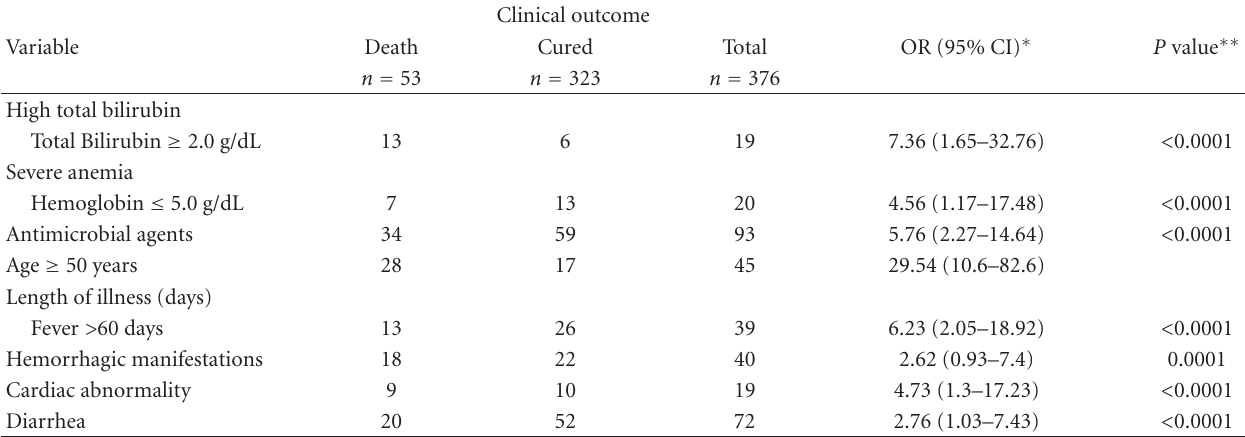
Table 4: Final model of factors associated with VL lethality, state of Sao Paulo, 1999–2005 (multivariate